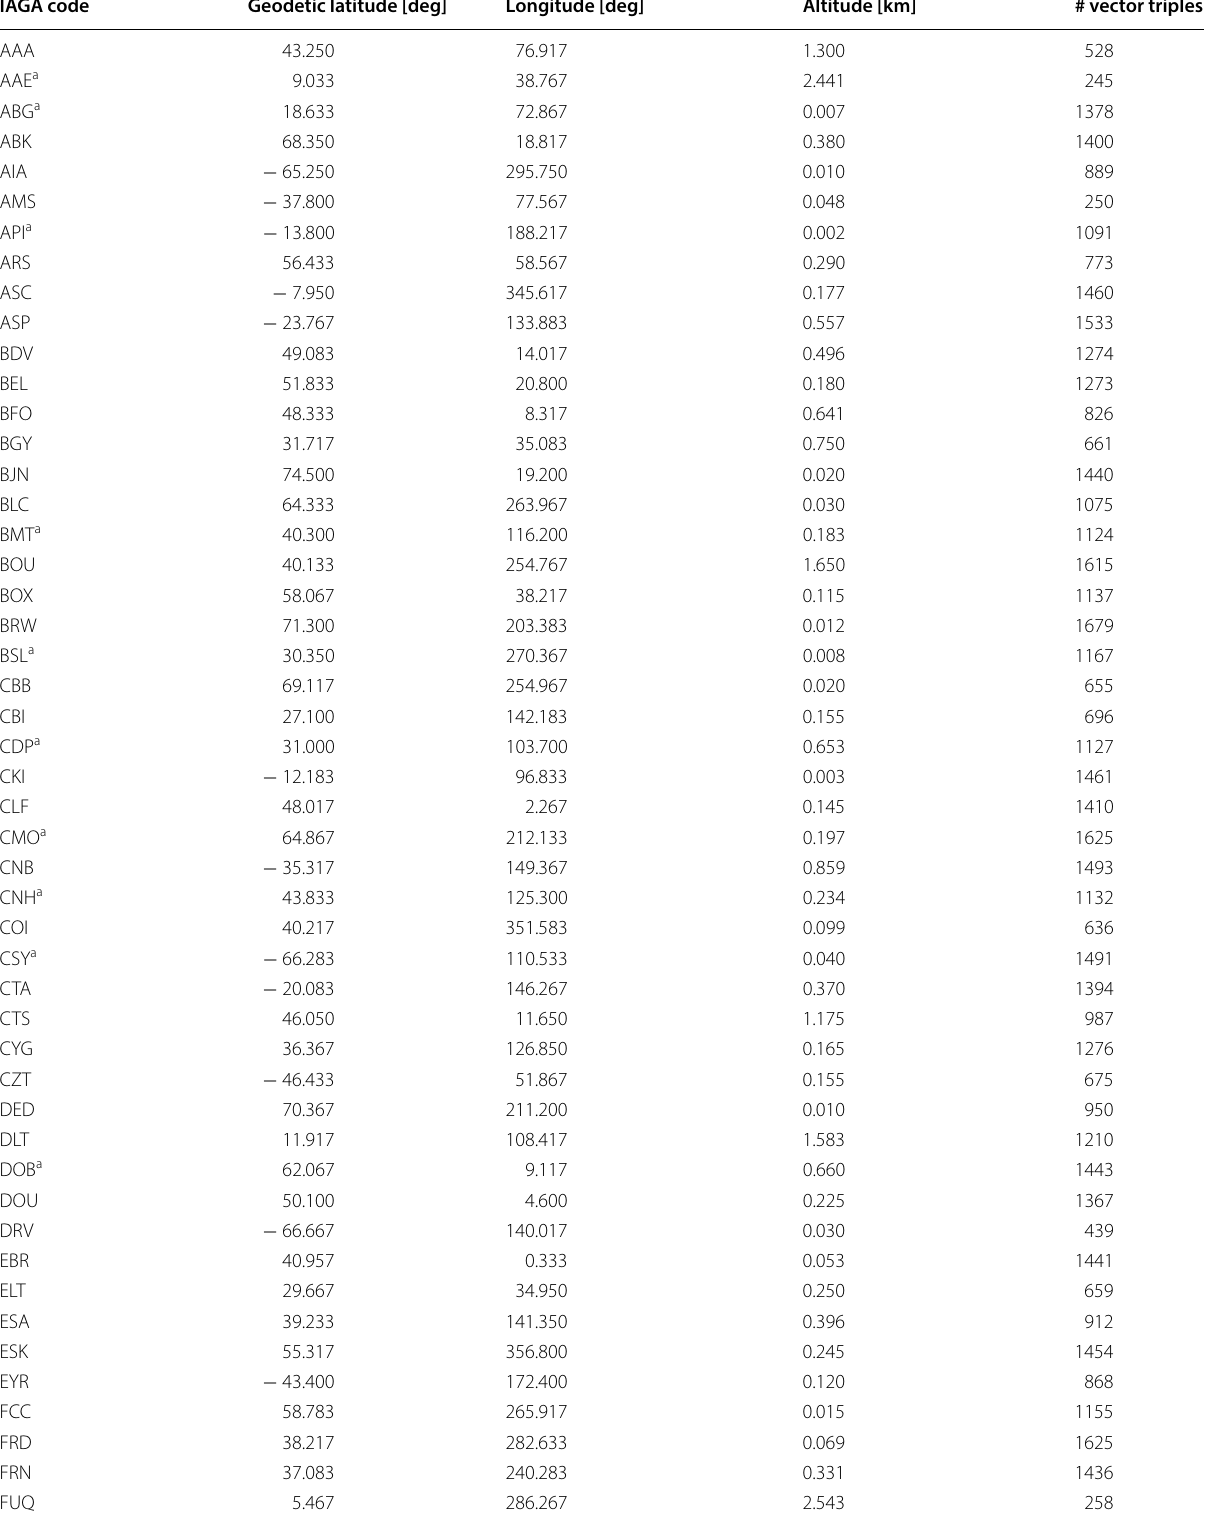
Table 2 Locations of ground observatories contributing data to the parent model, and number of data used IAGA